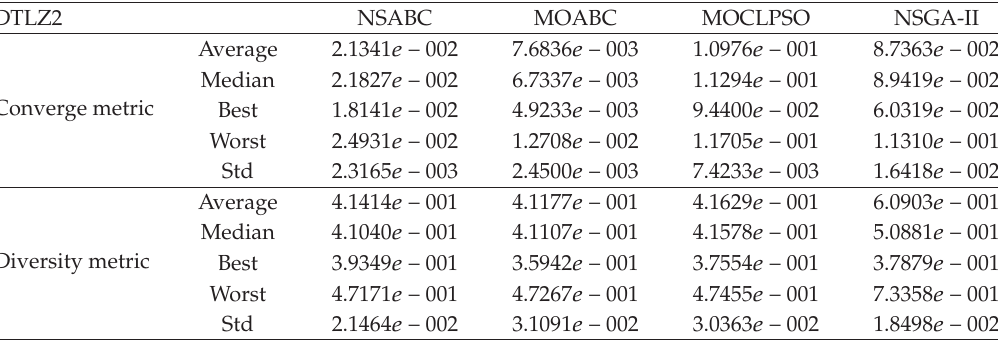
Table 17: Comparison of performance on DTLZ2 after 10000